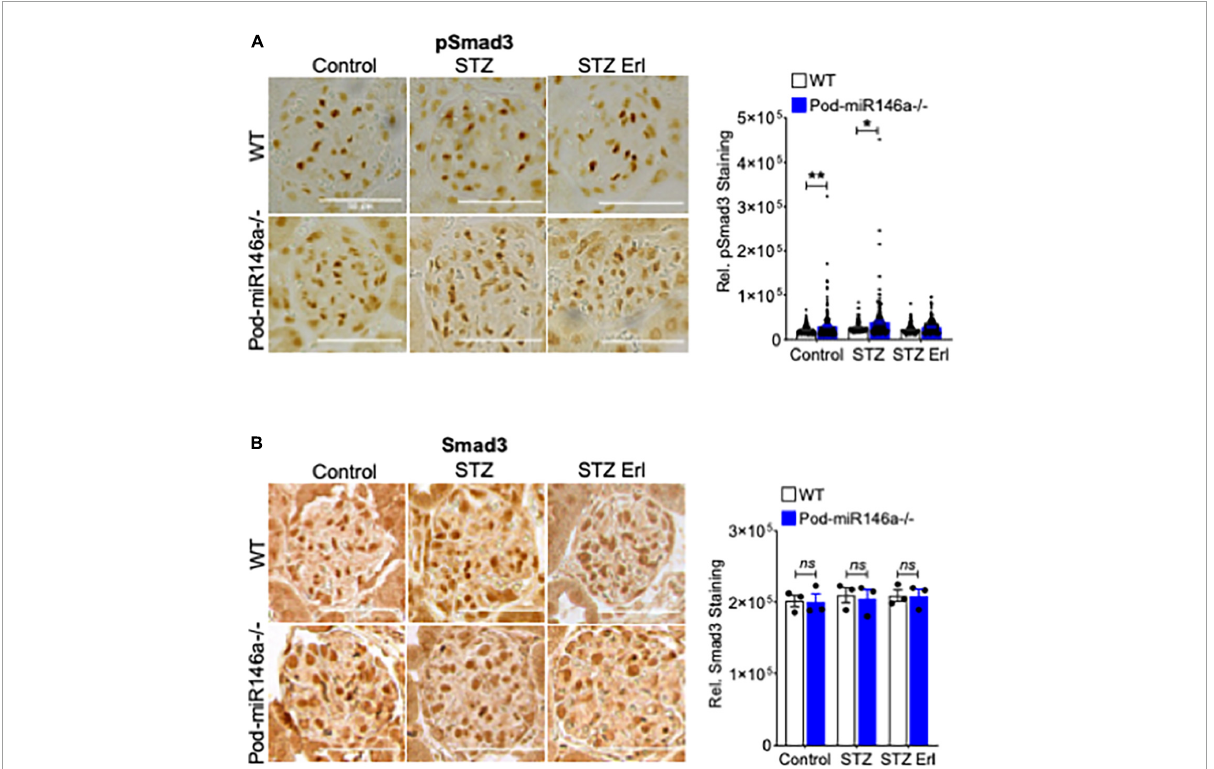
FIGURE6 Increase in glomerular pSmad3 levels by STZ treatment is suppressed by erlotinib. (A) Representative immunohistochemical images of glomeruli stained with an antibody against pSmad3 from WT (top row) and Pod-miR146a mice (bottom row) treated with vehicle alone (Control), with STZ and vehicle (STZ) or with STZ and erlotinib (STZ Erl). Scale bar, 50 µ m. Graph on the right shows quantification of pSmad3 positive cells per glomeruli in these samples. Statistics were performed using two-way ANOVA. Data shown are mean ± SEM ( n = 3). * p < 0.05, ** p < 0.01.